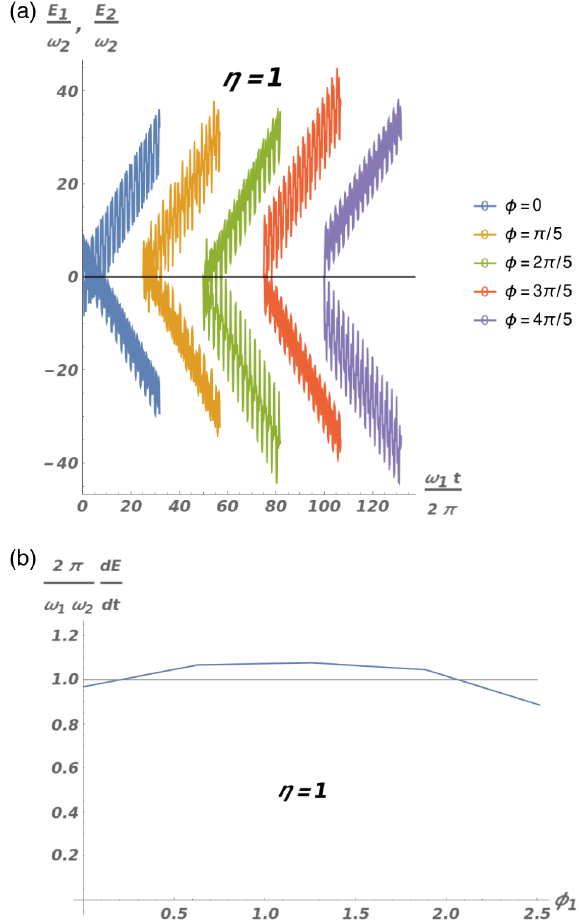
FIG. 6. The energy flow in the strong-drive regime, η ¼ 2 , for rational frequency ratio, ω 2 ¼ ð 3 = 2 Þ ω 1 , with Floquet state initialization. (a) The total work done by drives 1 and 2 as a function of time for different m ’ s. Each pair of lines is displaced on the time axis for clarity. (b) The power pumped as a function of the parameter m averaged up to time t ¼ 2000 . The pumping in the commensurate case could be stronger than its incommensu- rate counterpart. Furthermore, pumping may persist in the non- topological regime since the system does not average the Berry curvature of the entire Floquet zone. In the case of the offset angles chosen, even when m ¼ 2 . 2 , the system explores regions with net positive Berry curvature. The gray line is at dE=dt ¼ ω ω = 2 π ¼ 0 . 002387 , signifying the pumping due to 1 2 Berry curvature of the Chern number C ¼ 1 band. The initial phases for these plots are ϕ 1 ¼ π = 10 ; ϕ 2 ¼ 0 .